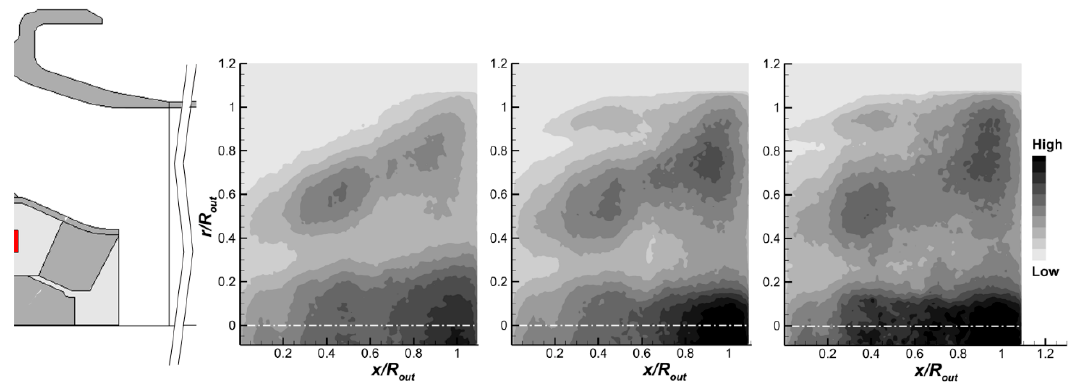
Figure 7. PLIF measurements: RMS of OH concentration maps for (from left side to right side) operating conditions from #1 to # 3 ( λ = 3.60, 3.25, and 2.90, respectively).